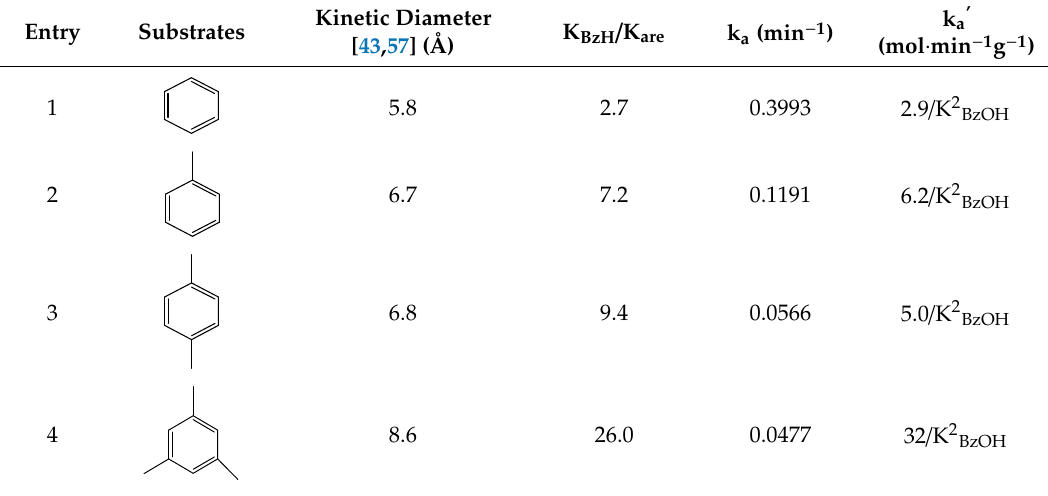
Table 4. Kinetic results of adsorption and surface reaction in the benzylation of aromatics.